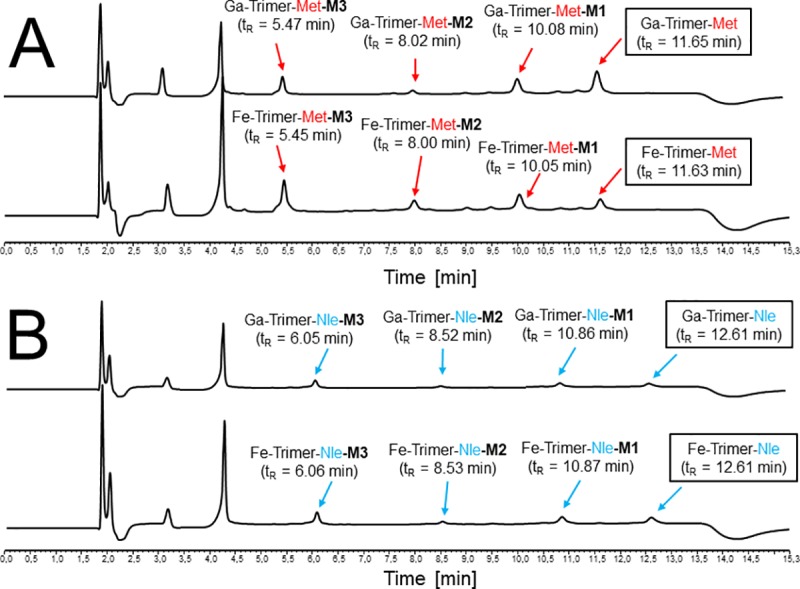
In vitro metabolite assessment of non-radioactive trimers by artificial enzymatic degradation.Representative RP-HPLC chromatograms of artificial enzymatic degradation in vitro of metal chelated trimeric Met- (A) and Nle (B) conjugates.